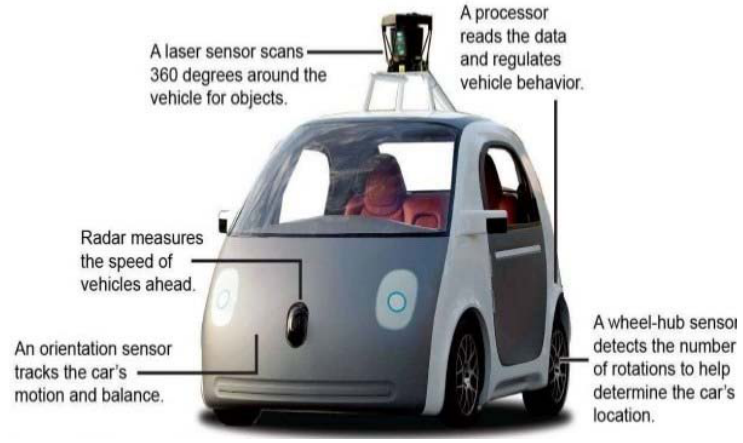
Figure 7. Basic sensors of Google’s driverless car. Source: http://blog.cayenneapps.com/2016/06/13/self-driving-cars-swot-analysis.